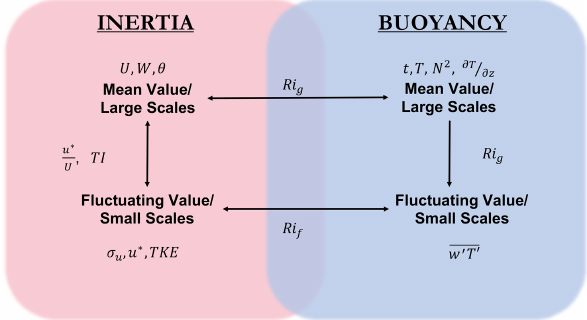
Figure 2. Illustrative breakdown of the scales and variables related to inertial and buoyant forcing; θ (cid:48) is not shown as it is not utilized in the